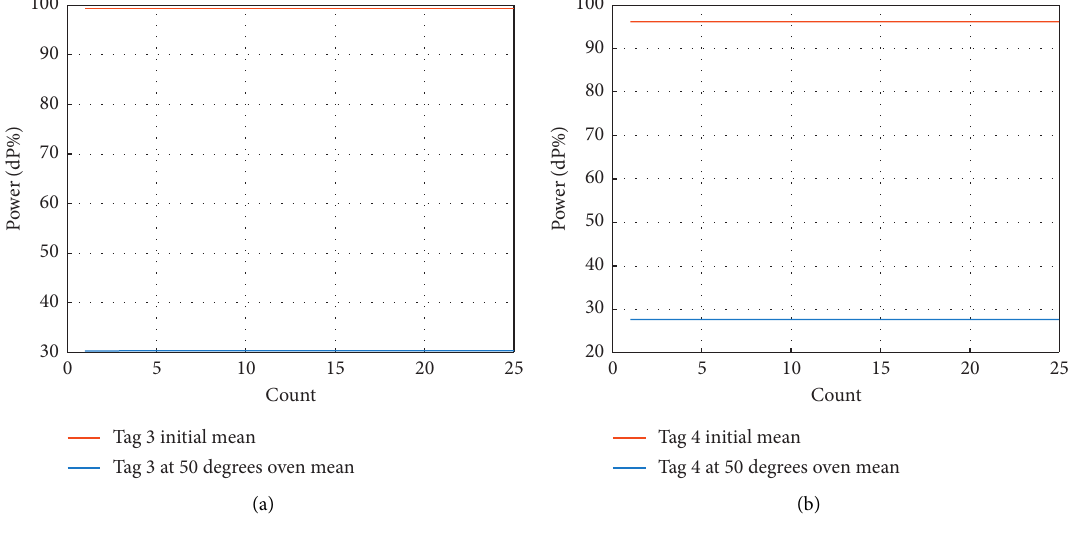
Figure 11: Change in dP% from the initial state to the bent state for Tag 3 (a) and Tag 4 (b).